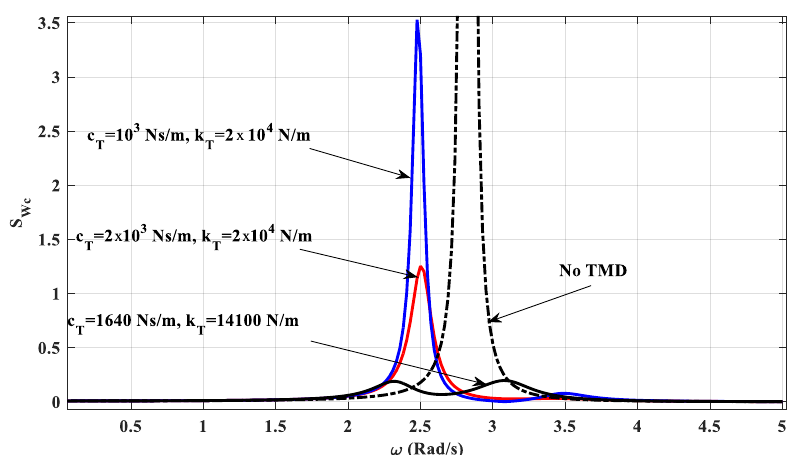
Figure 10. The spectral density function in the frequency